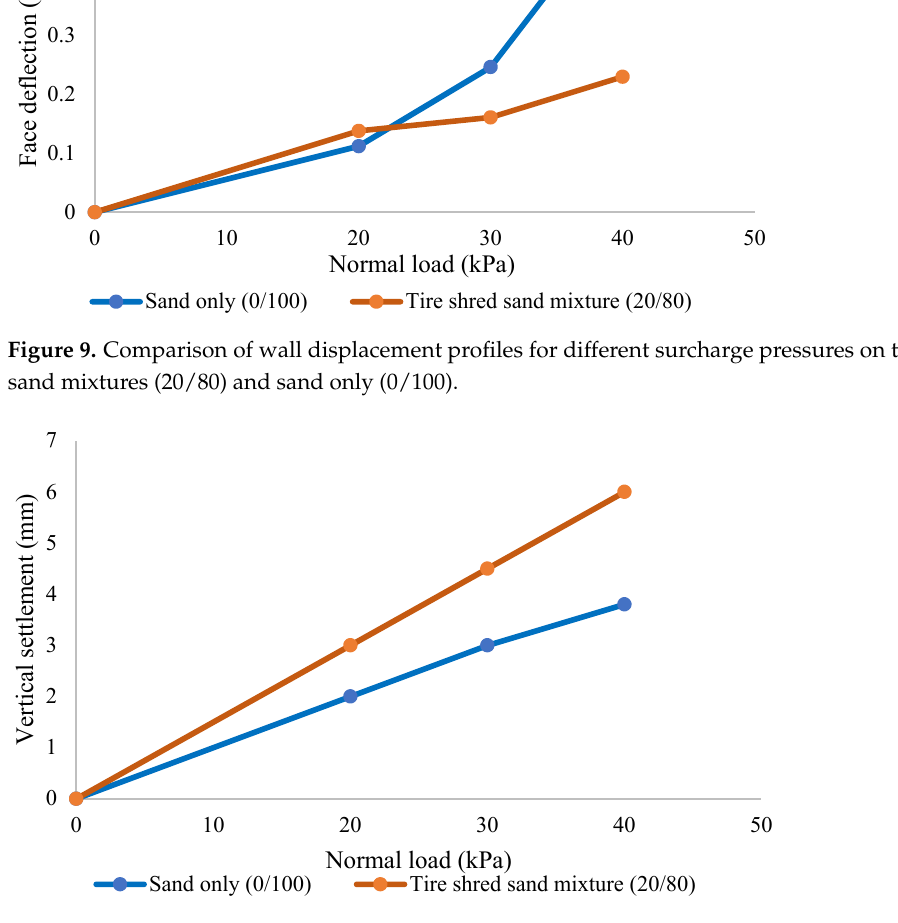
Figure 10. Comparison of vertical settlement with surcharge pressures on tire shred-sand backfill (20/80) and sand only (0/100).